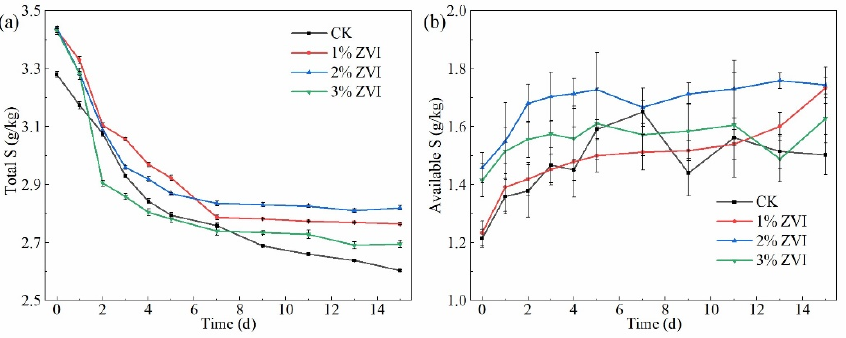
Figure 4. Changes in total sulfur ( a ) and available sulfur ( b ) content of the compost material under different ZVI additions. ZVI: zero-valent iron.